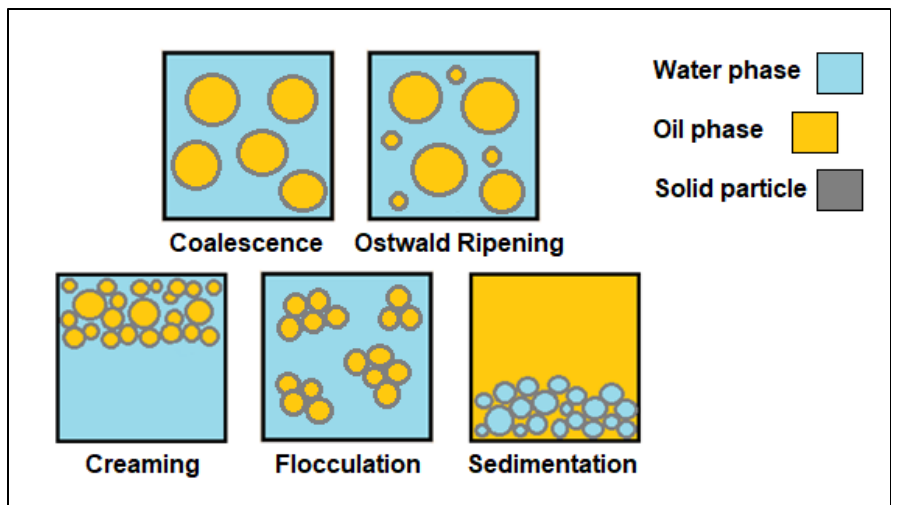
Figure 6. Schematic diagram of the different physical instability of the emulsion.